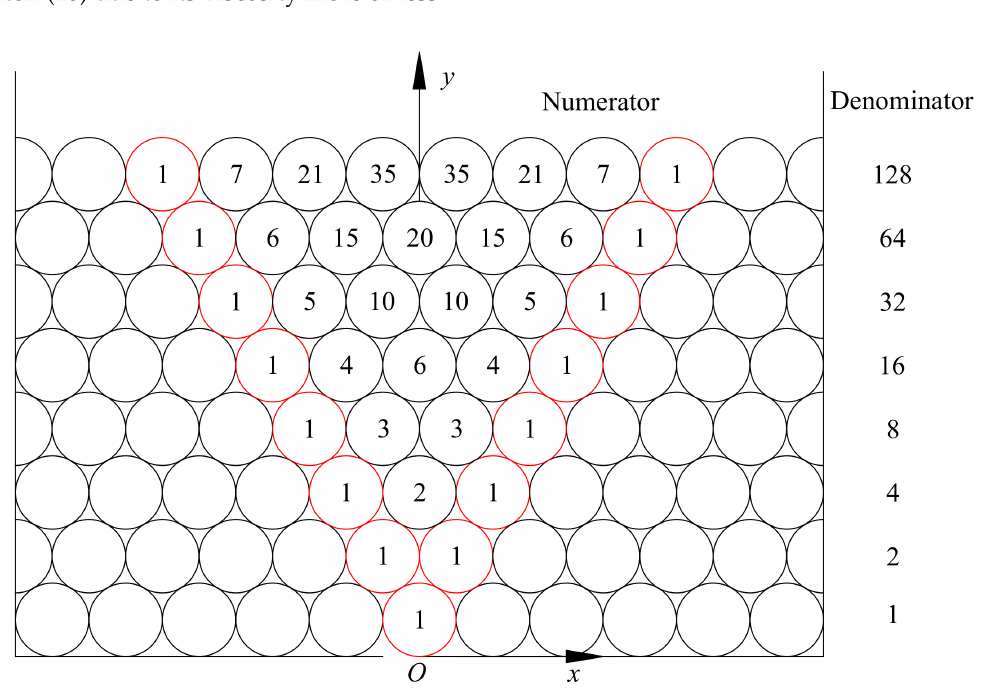
Figure 4. Theoretical model of granular media movement in the SM